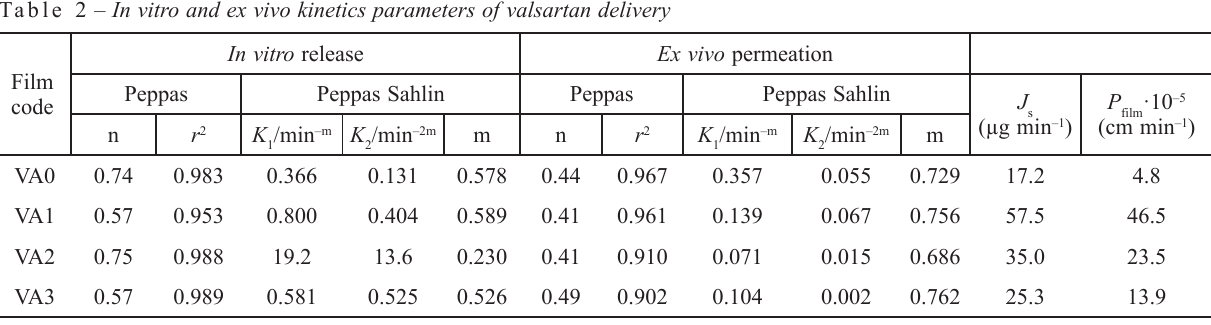
Table 3 – Dunnett Test (two-sided)/Analysis of the differences of permeation coefficient between the control group and the other categories with a confidence interval of 95 % Standardised Critical Contrast Difference difference